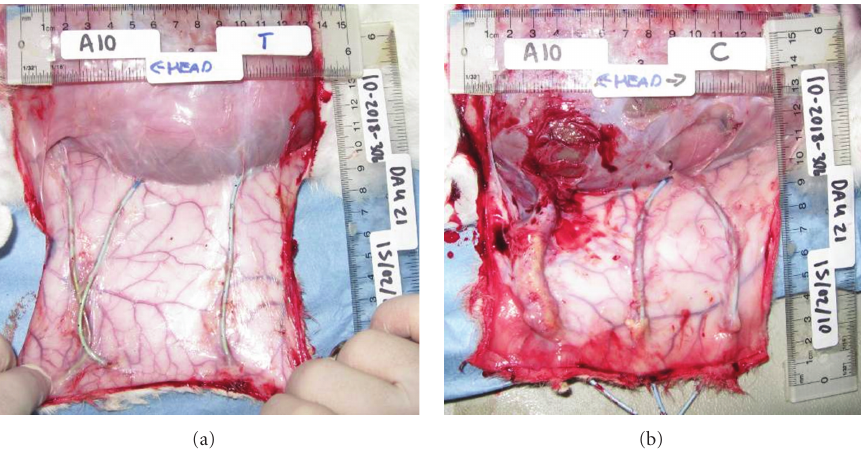
Figure 3: Representative digital micrographs taken during catheter explant and necropsy on rabbit 10. (a) Test article side: note that the fibrous capsule is minimal, and there is no evidence of pus or irritation. (b) Control article side: the digital image demonstrates indicators of infection uniformly across the three control replicates. Extensive pus, hyperemia, and fibrosis can be seen associated with the tissue around the control